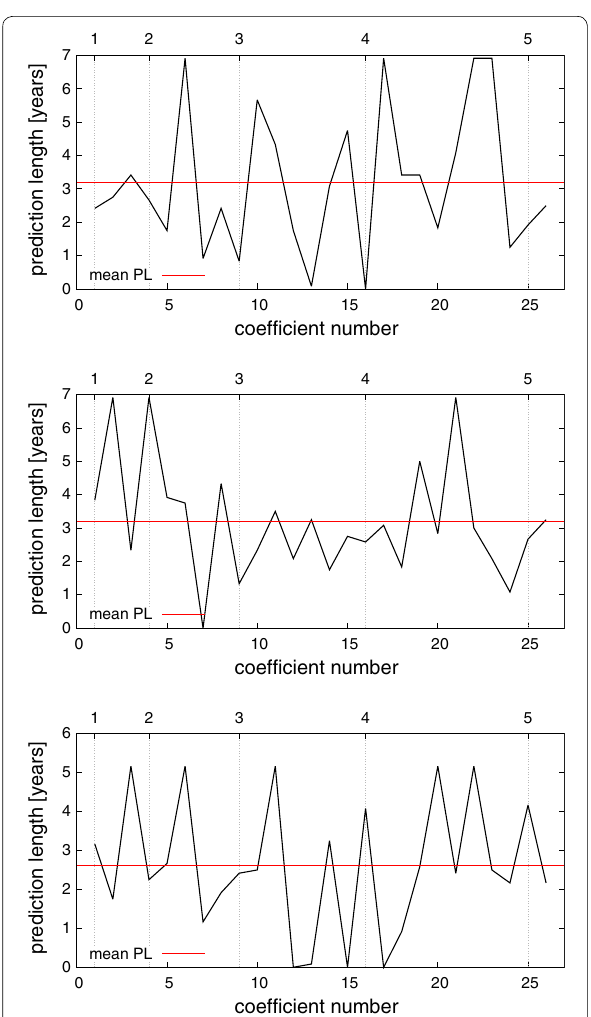
Fig. 11 Prediction lengths defined by the time interval when sAPE(t) < 10% of different forecast experiments base on Model 1 with forecasts started in 1995 (top panel), in 2005 (middle panel) and in 2015 (bottom panel), respectively. The solid horizontal red lines represent mean prediction lengths in years derived from the first 26 secular variation coefficients, i.e., ˙ g 0 1 ... ˙ g 1 5 . Top axes indicate degrees of the spherical harmonic